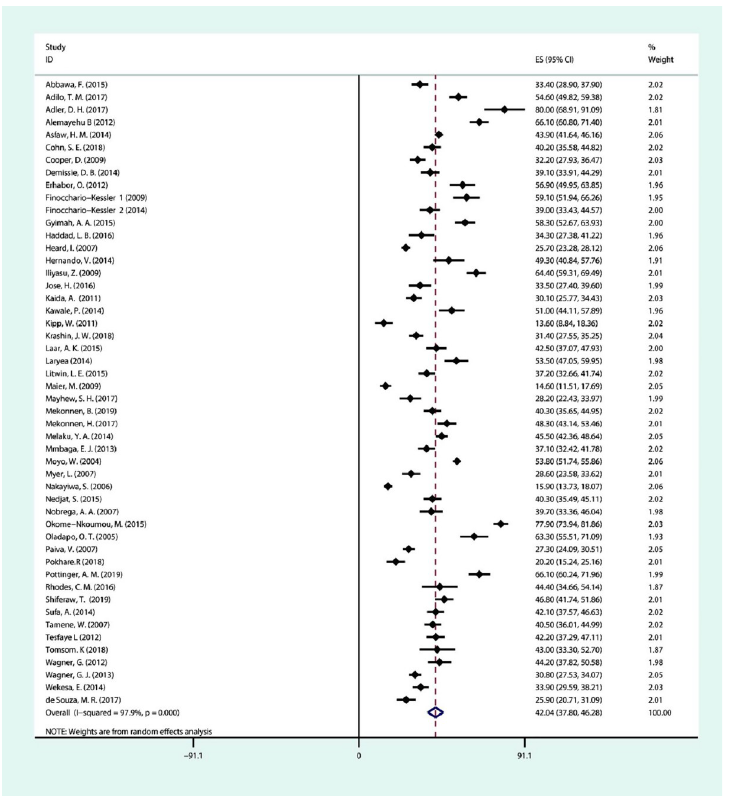
Fig 2. Forest plot of the overall prevalence of fertility desire among people living with